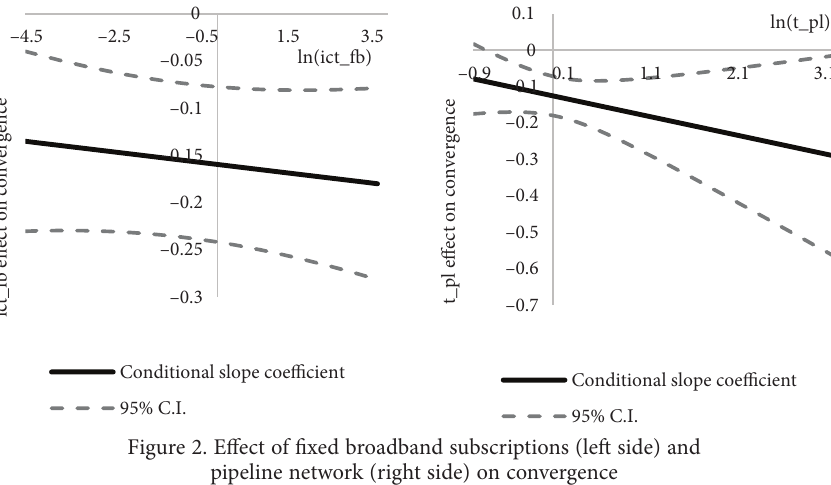
Figure 2. Effect of fixed broadband subscriptions (left side) and pipeline network (right side) on convergence